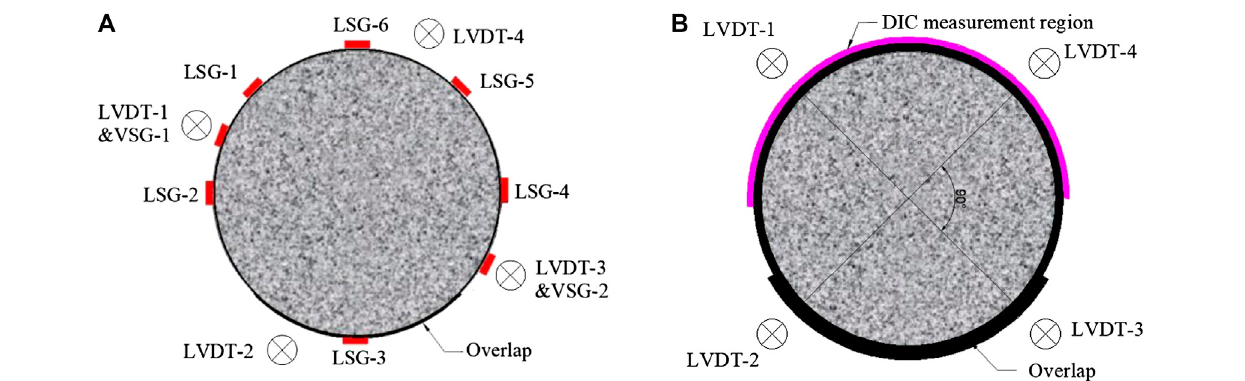
Figure 8 | LVDTs and strain gauge distribution: (A) CFRP- con fi ned concrete and (B) LRS FRP-con fi ned concrete.